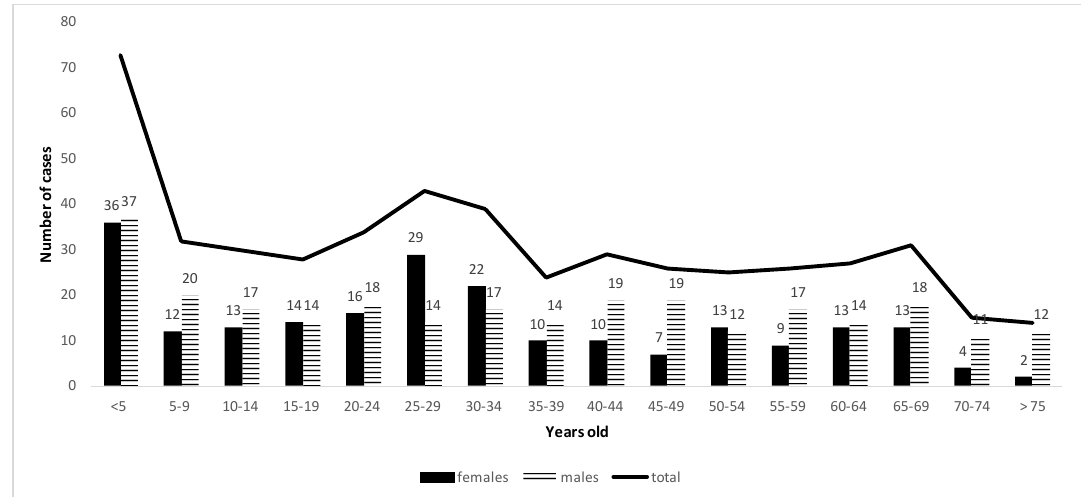
Figure 2. Demography of cryptosporidiosis reported cases from 2017 to 2019 in tertiary care public hospitals in France.